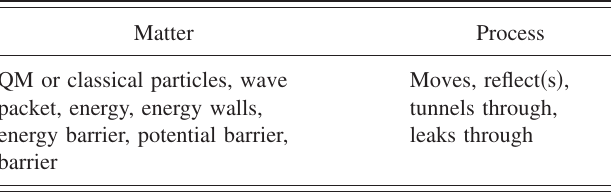
TABLE IV. Ontology of the potential wall metaphor. Matter